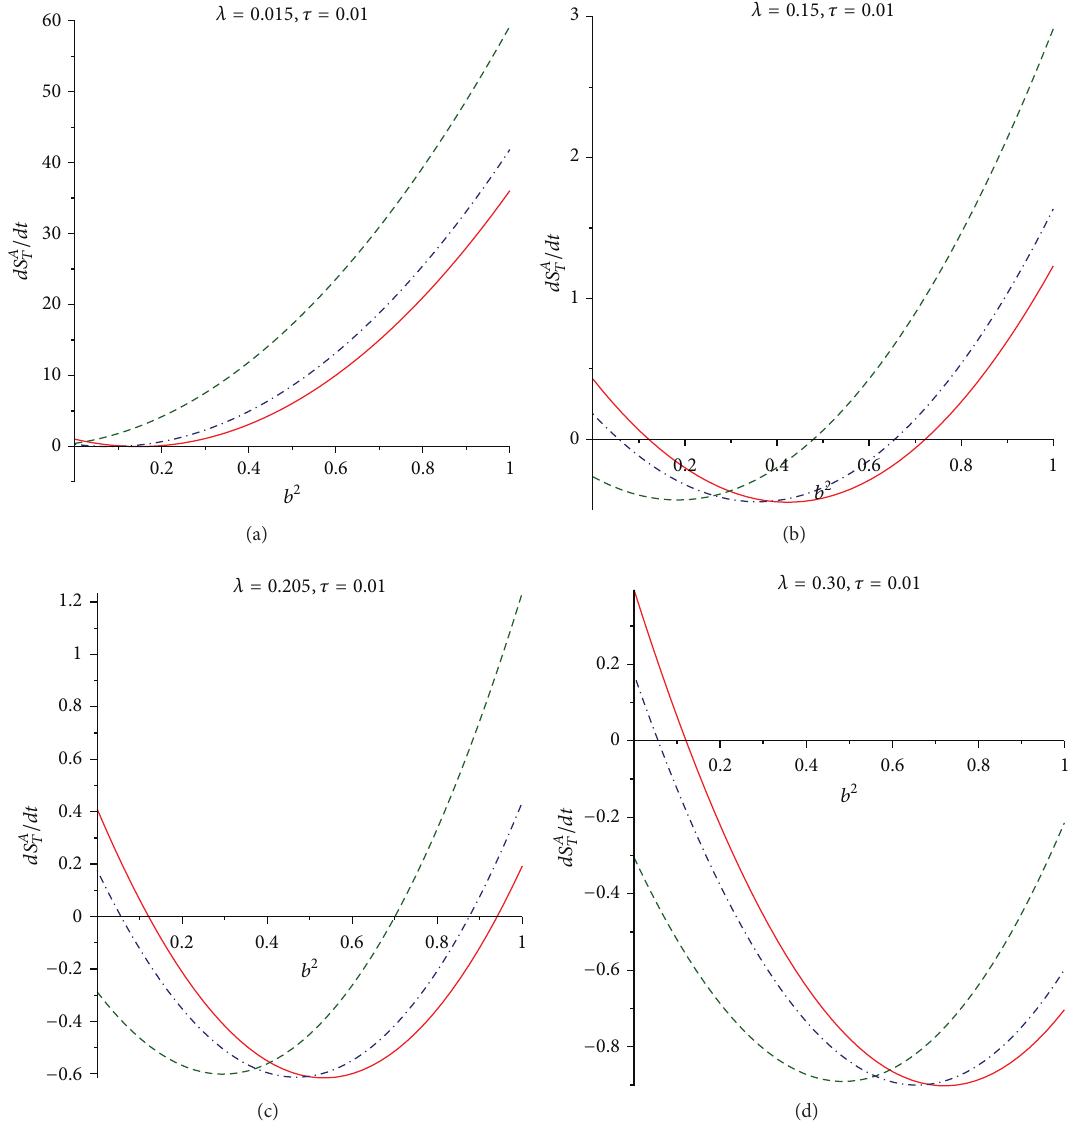
Figure 1: The above 4 plots show the variation of 𝑑𝑆 𝐴 𝑇 /𝑑𝑡 against the coupling parameter 𝑏 2 for different values of 𝜆 and for 𝜏 = 0.01 . The red (solid), green (dash), and blue (dash-dot) curves correspond to data sets 1, 2, and 3, respectively.